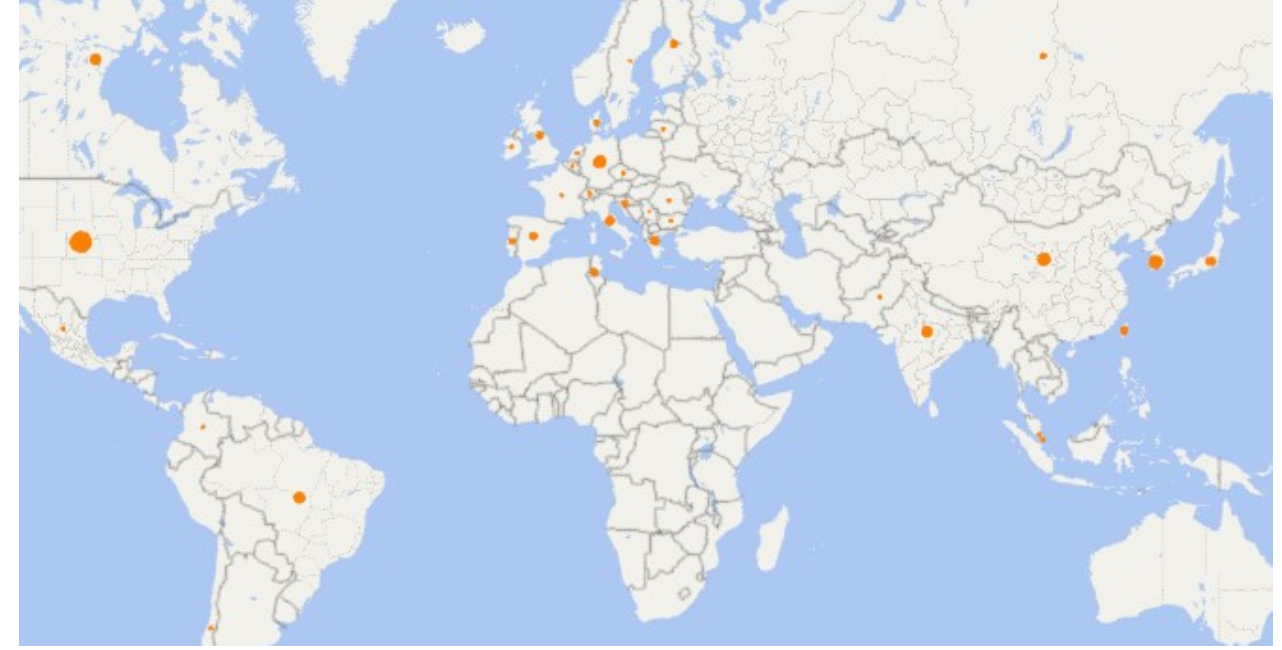
Fig. 2. Publications categorized according to the country of author’s institution.